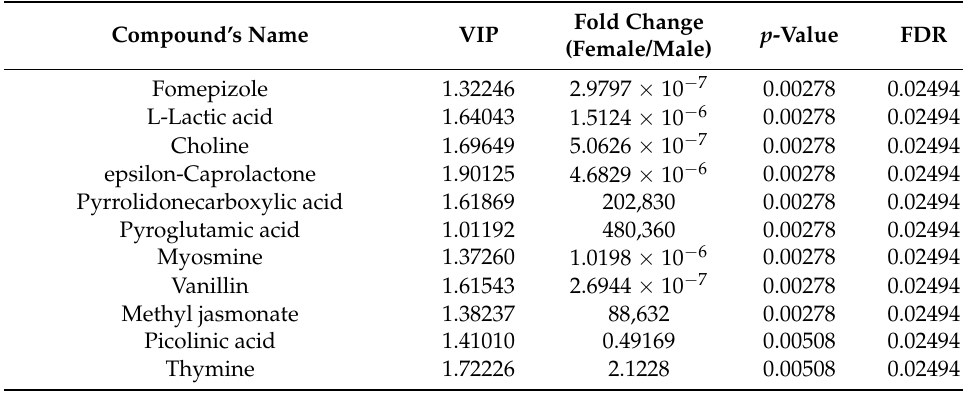
Figure 5. Heat map of volatile metabolites: ( A ) hierarchical clustering based on all 24 volatile sub- stances identified in 80 significantly differential metabolites between the two sexes, ( B ) hierarchical clustering showed that five volatile substances could distinguish the sex groups of ducks. In classi- fication, red represents DM and yellow represents DG. In legend, the color represents the relative content. The redder the color, the higher the expression level, and the bluer the color, the lower the expression level. Values are Z-score normalized for peak responses of metabolites. Table 2. The differential expressed 24 volatile